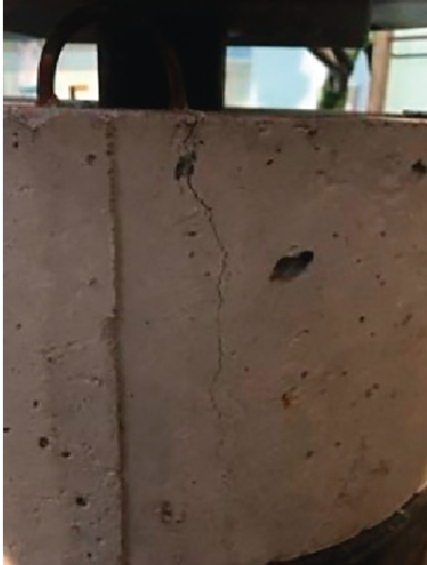
Figure 5: Longitudinal